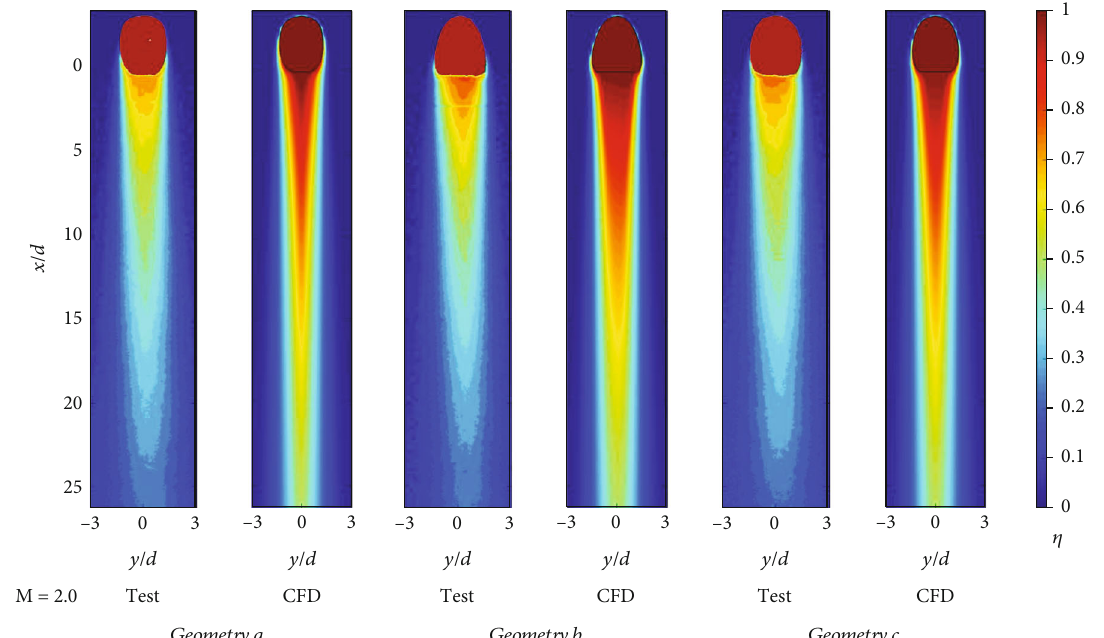
Figure 12: Test and CFD comparison of e ff ectiveness contours for the blowing ratio of 2.